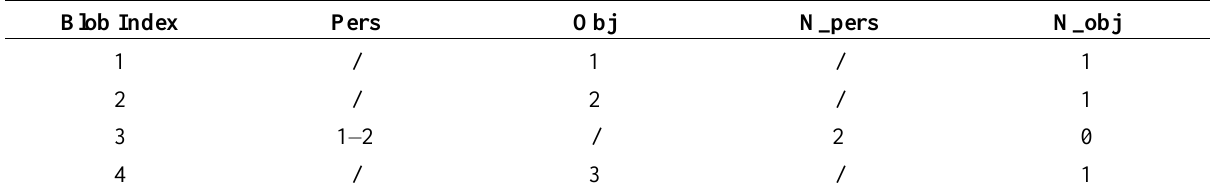
Table 2. Each of the previously discussed cases requires calling the function IsPerson that separately